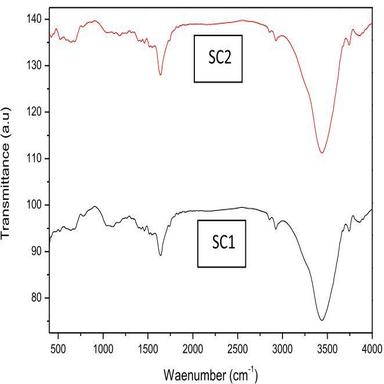
FT-IR of SiO2@C powders prepared from rice husk.